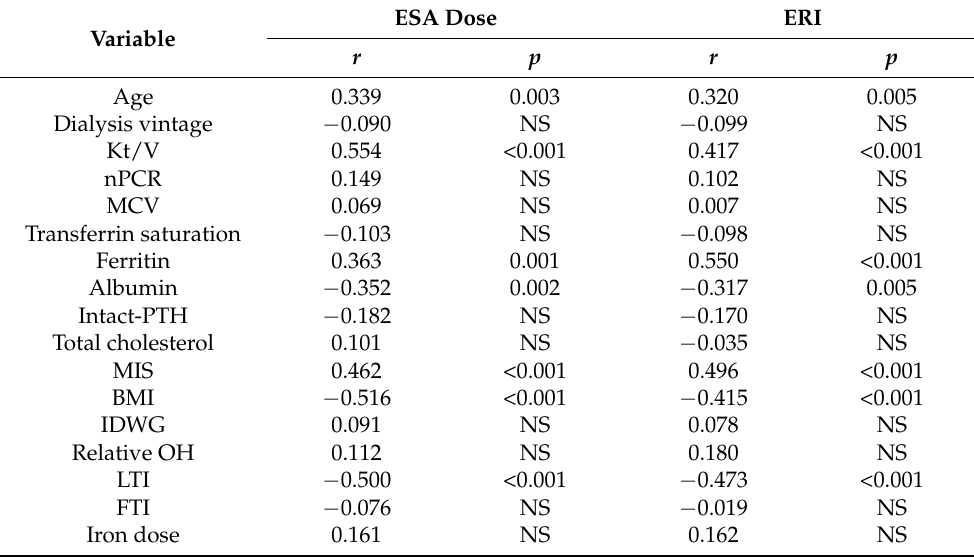
Table 4. Bivariate correlations of ESA responsiveness with relevant parameters.